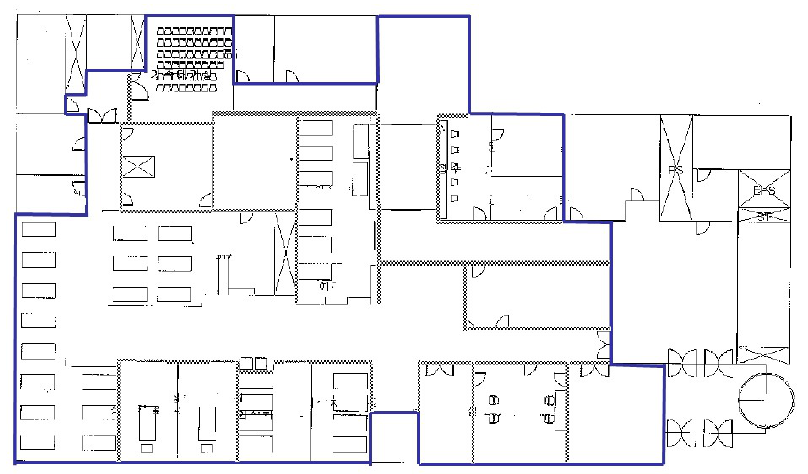
Figure 3. Map of the emergency